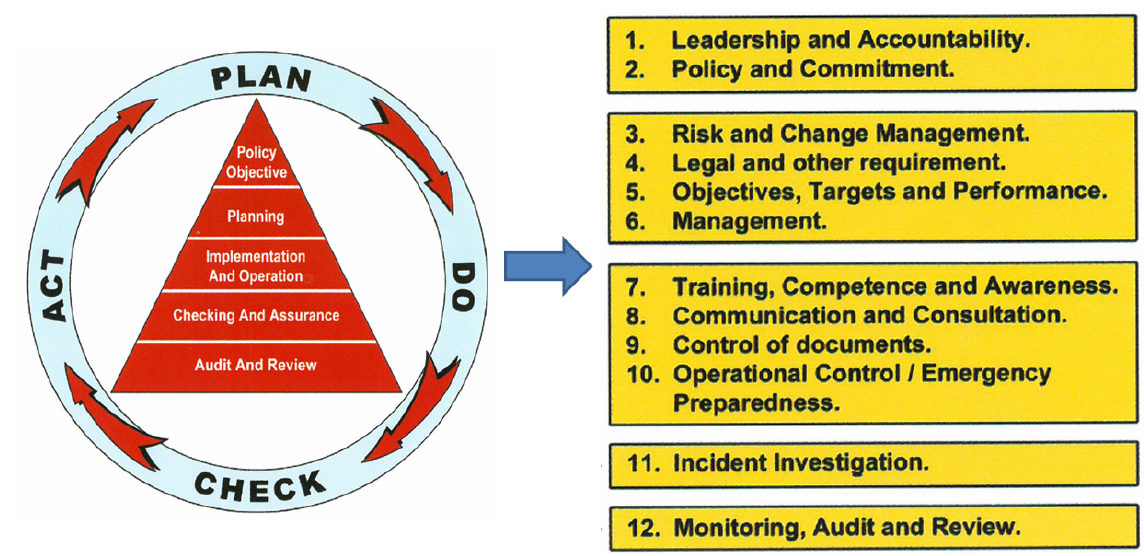
Figure 3. The UK Coal safety management system.